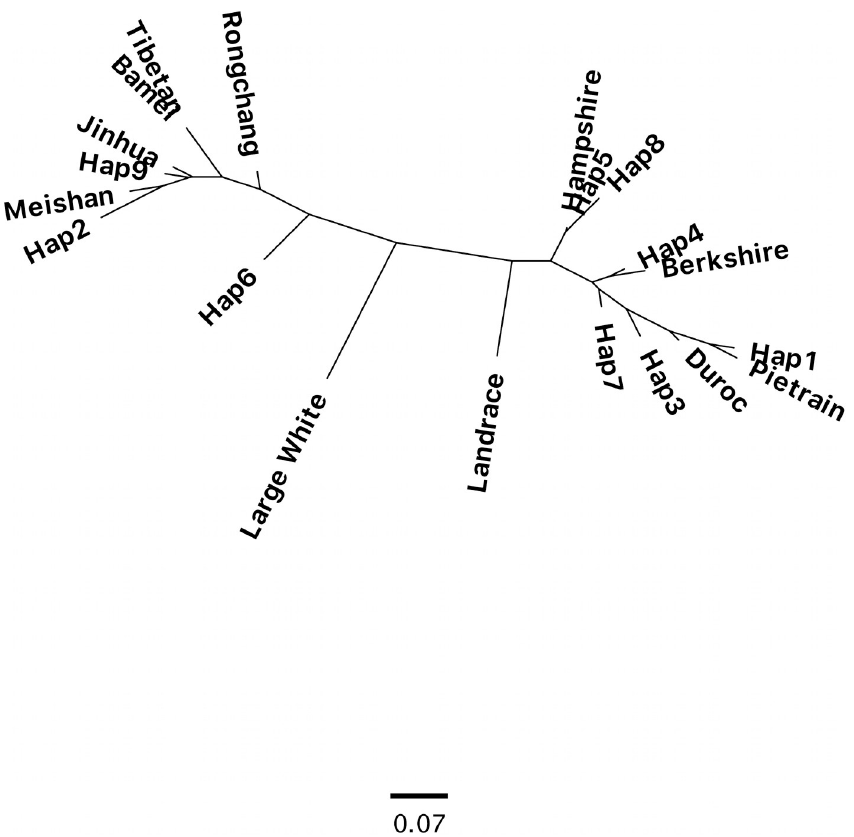
Fig 7. Phylogenetic tree of haplotypes from the LD block between ALGA0110477 and SYNGR2 (SSC12) in our resource population ( Hap1–9 ) and selected domestic pig breeds.